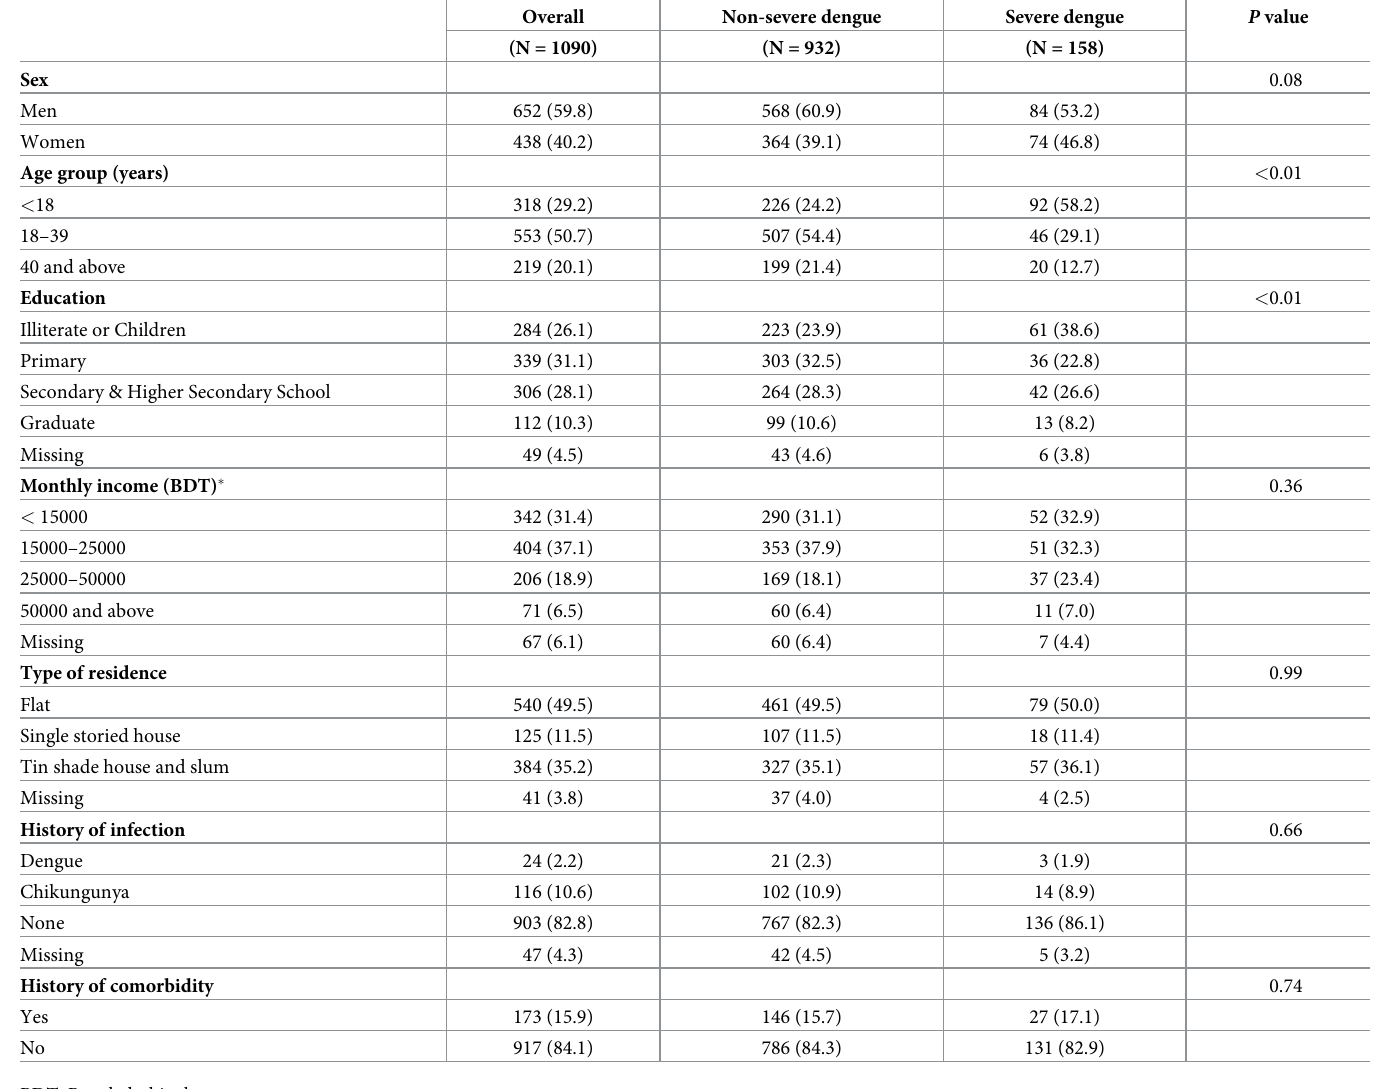
Table 1. Socio-demographic characteristics of the dengue cases �